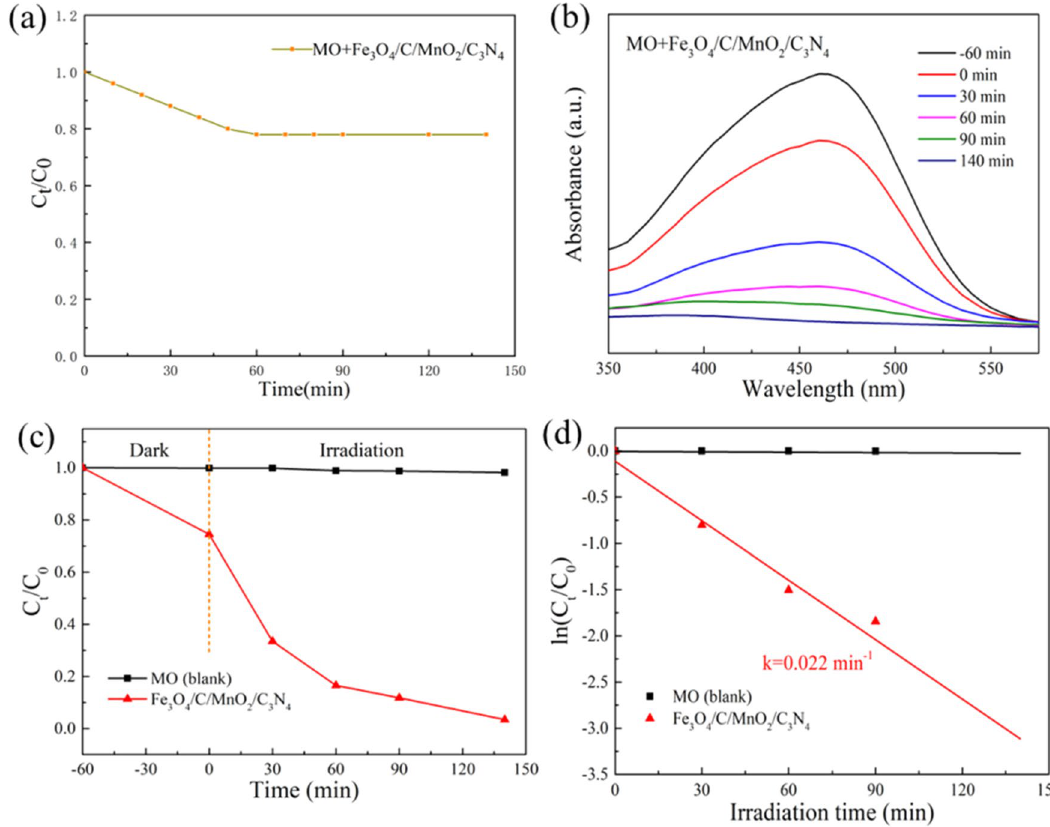
Figure 6. Adsorption of MO on sample in dark reaction ( a ), UV–vis spectra of MO solution at different times in the presence of Fe 3 O 4 /C/MnO 2 /C 3 N 4 photocatalyst ( b ), C t /C 0 change with time ( c ), first-order kinetic model linear fit ( d ). Reaction conditions: [MO] = 65 mL, 10 mg/L, [photocatalyst] = 20 mg, [light] = 400 W metal halide lamp, T = 25 °C, t = 140